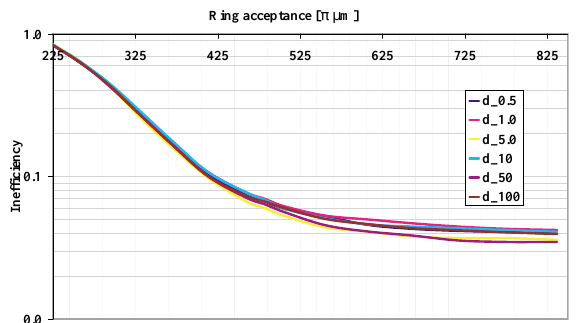
FIG. 12. (Color) Cleaning efficiency as a function of the halo drift velocity. Velocity is given in s (cid:1) m where s is the rms transverse beam size.